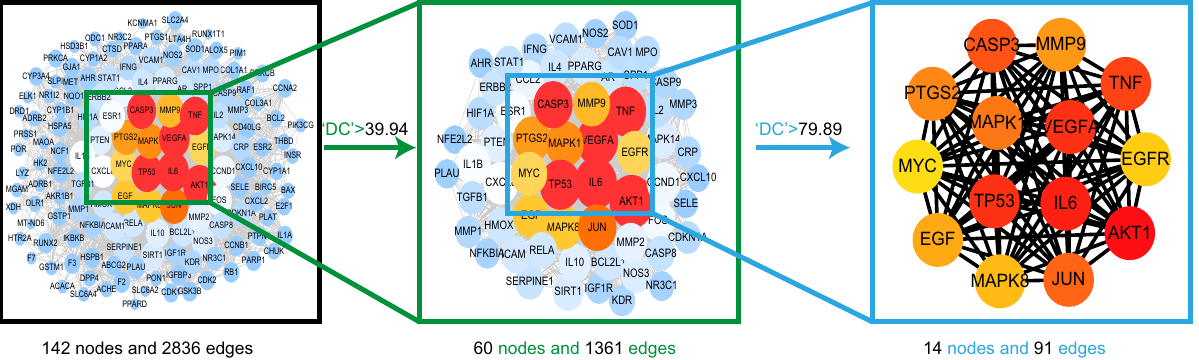
Figure 6. Core targets topology. The figure shows the topology of the PPI network. The color of the targets changes from blue to red according to the DC value, and red represents the core targets. The black box shows all the targets, the green box shows the targets whose DC value is greater than 1 times the median, and the blue box shows the targets whose DC value is greater than 2 times the median, which are the core targets of this study.